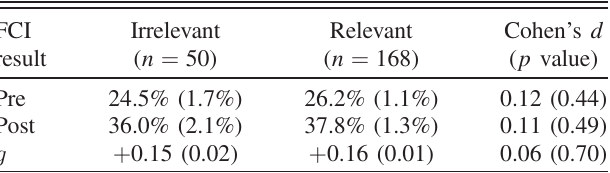
TABLE II. Average FCI pretest and post-test score percentages and normalized gains, comparing between students with a relevant view of physics and students with an irrelevant view. Standard error is included in parentheses next to each average value for the irrelevant and relevant columns. All comparisons had statistically equal variance ( F test: p > 0 . 05 ). Adapted from Table 2 in Ref.